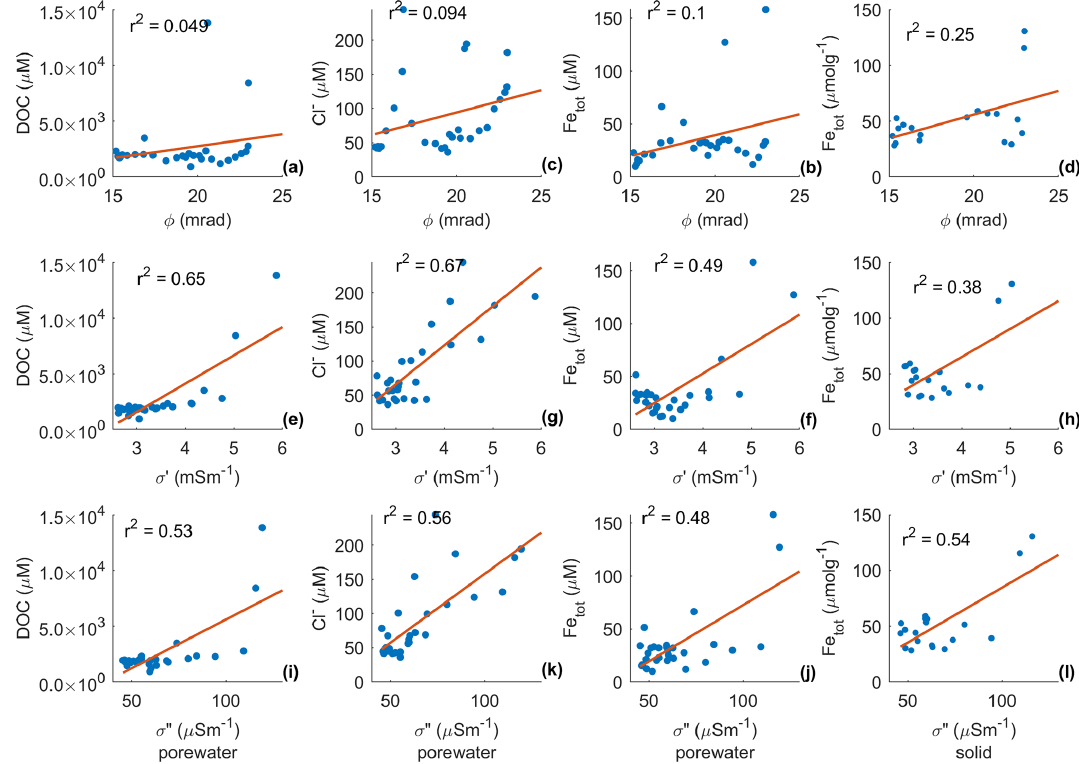
Figure 10. Correlations between the geophysical and geochemical parameters, phase ( φ ), the real ( σ (cid:48) ) and imaginary ( σ (cid:48)(cid:48) ) components of the complex conductivity (retrieved from the imaging results) and the biogeochemical analysis, expressed in terms of the dissolved organic carbon (DOC), and chloride (Cl − ) content from the pore-fluid samples and total iron (Fe tot ) content from pore fluid in µmolL − 1 and solid samples in µmolg − 1 . The correlation coefficients of least-square regression analysis are shown in the top left corners of the